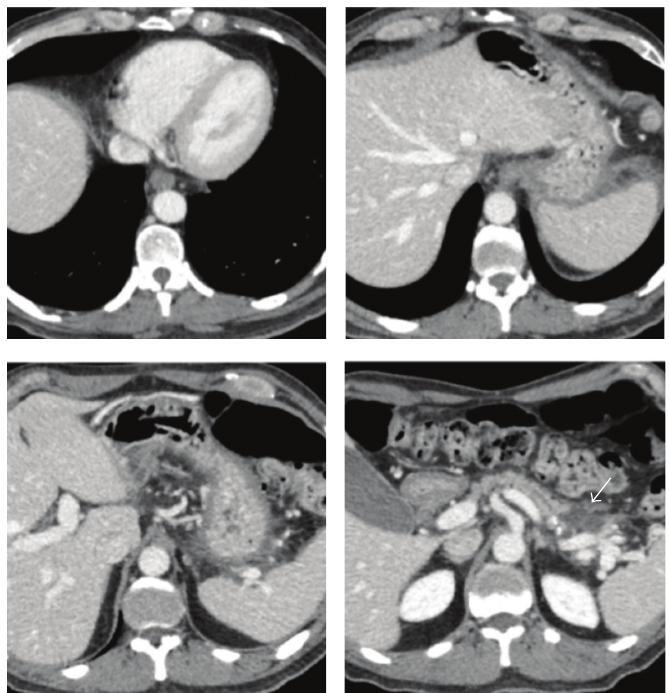
Figure3:Axialimagesofcontrast-enhancedCTobtainedaboutfiveweeksafteradmissionshowapseudocyst(3 cm)(arrow)inthepancreatic tail and the complete resolution of both mediastinal fluid collections and pleural